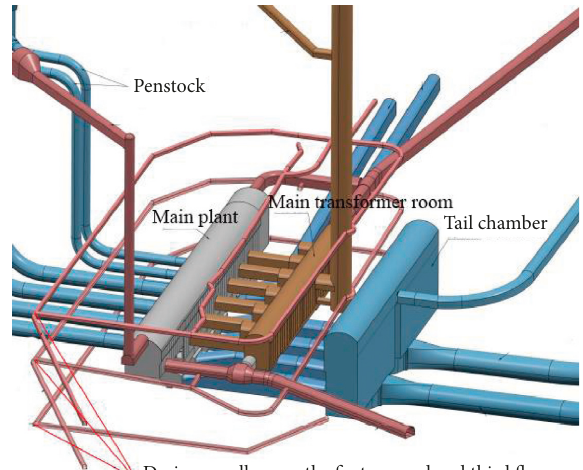
Drainage gallery on the first, second and third Figure 11: A total of three layers of antiseepage drainage corridors are designed for the underground